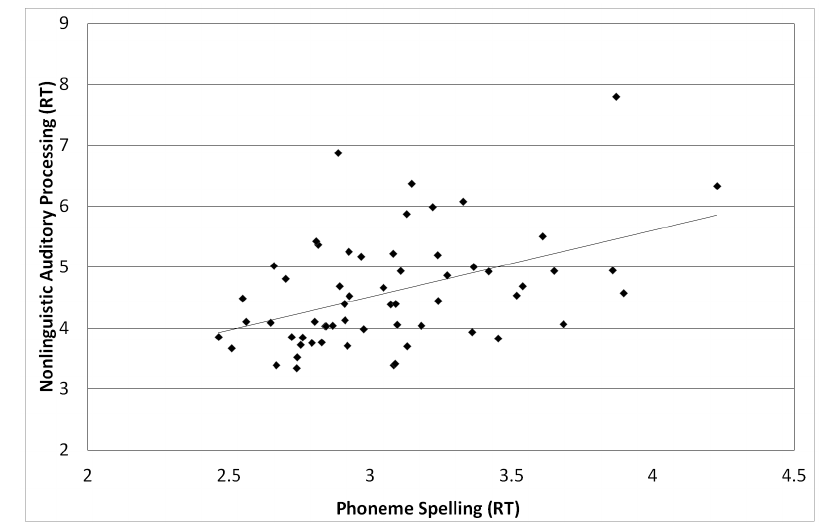
Figure 2. Correlation between RTs on nonlinguistic auditory processing and phoneme spelling, r (58)= .45, p , .001.